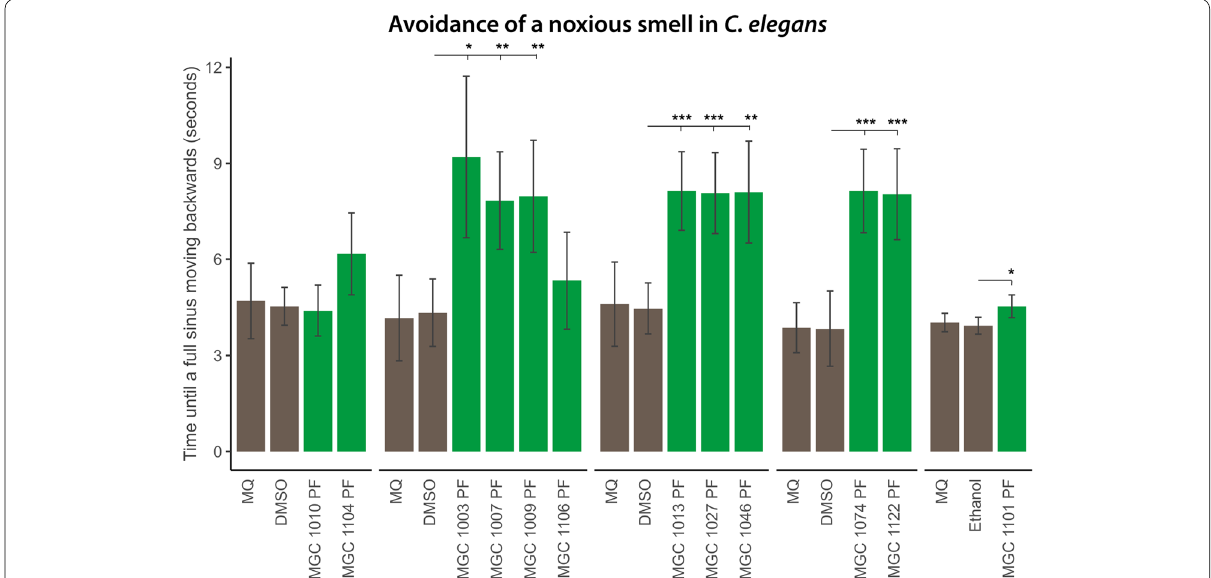
Fig. 5 Effect of polar fractions (PFs) of different varieties on the avoidance of a noxious smell. The effect of the polar fractions (PFs) on the nervous system was assessed by the effect on the time of one full reversal backwards movement of 1‑octanol treated C. elegans exposed to 100 μg/mL PFs of different varieties. Treatment with PF of varieties: MGC 1003, MGC 1007, MGC 1009, MGC 1013, MGC 1027, MGC 1046, MGC 1074, MGC 1122, and MGC 1101 all reduced the responsiveness of nematodes to the aversive odor 1‑octanol. MQ indicates the Milli‑Q water control group, DMSO (dimethyl sulfoxide) and ethanol the vehicle control. Mann‑Whitney U tests were used to compare the vehicle control conditions (DMSO/ethanol) to the experimental conditions. Green bars denote the effect on avoidance by C. elegans exposed to PFs of different cannabis varieties; brown bars denote vehicles; *** false discovery rate (FDR)‑corrected p < .001; ** FDR‑corrected p < .01; * FDR‑corrected p < = = =